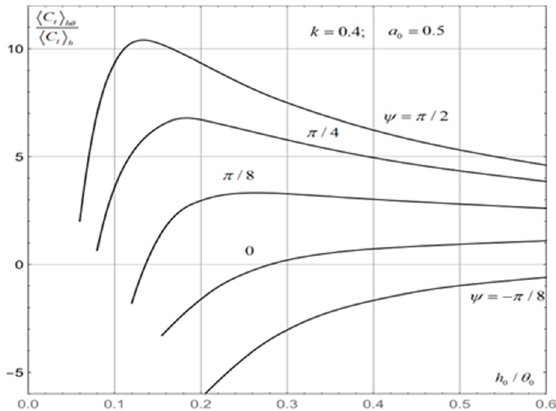
. . 0.5 a = and aspect 0.5 a = and aspect 0 0